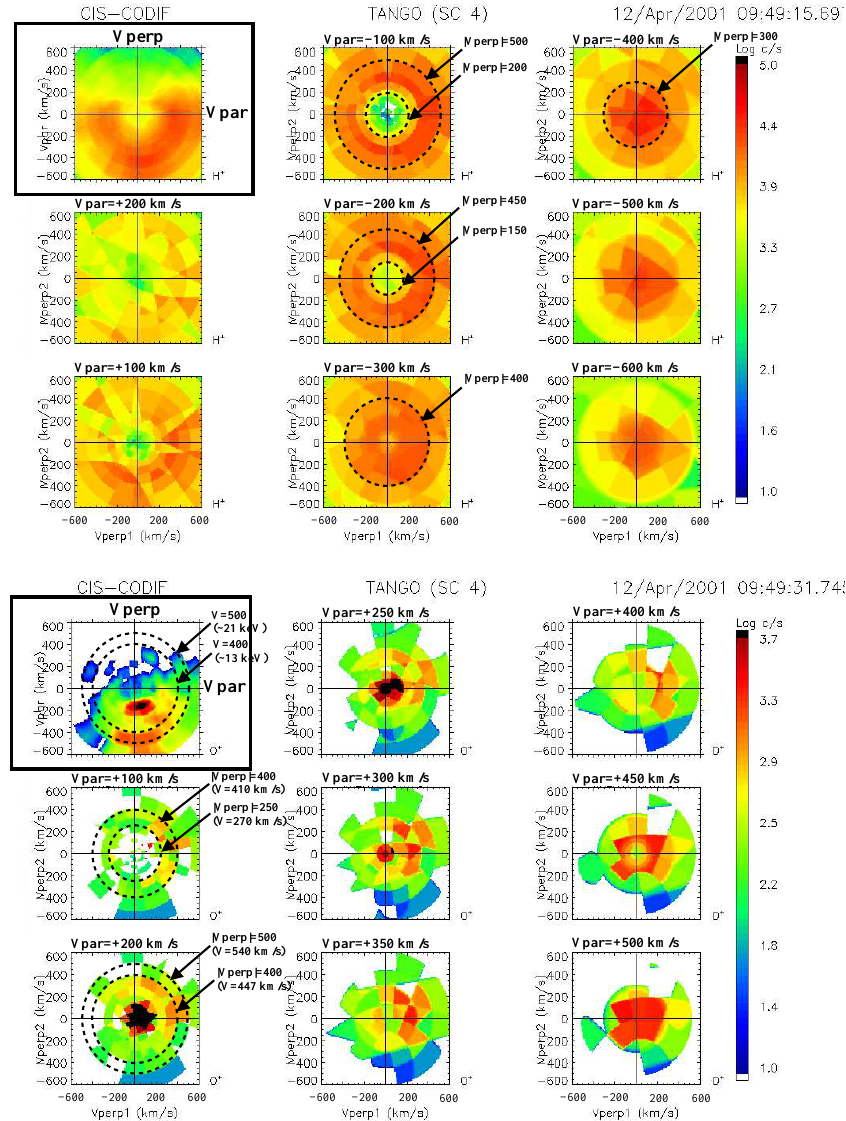
Fig. 3. H + (upper)/O + (lower) ion velocity distributions in counts per second (c/s) observed by the Cluster S/C-4. The construction of the panel is the same as that of Fig. 2. There was a 5-s time interval between two spacecraft and the interspacecraft distance was about 807km. There is no available H + velocity distribution comparable to O + velocity distribution at 09:49:31 UT; therefore, the distribution at 09:49:15 UT is shown for H +